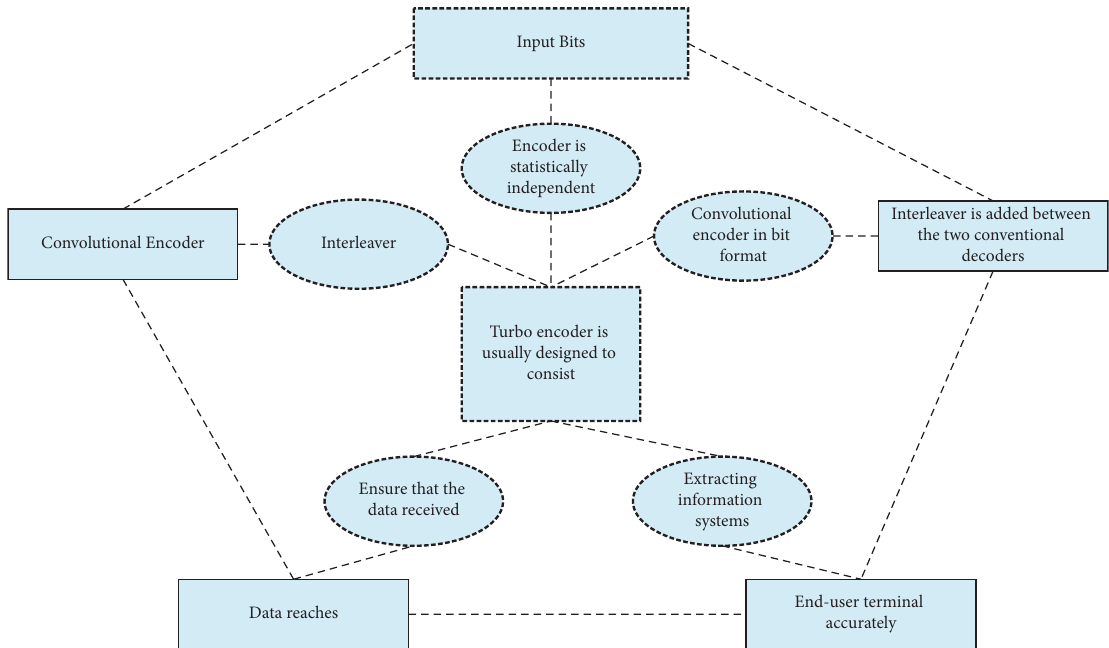
Figure 5: Structure of Turbo code